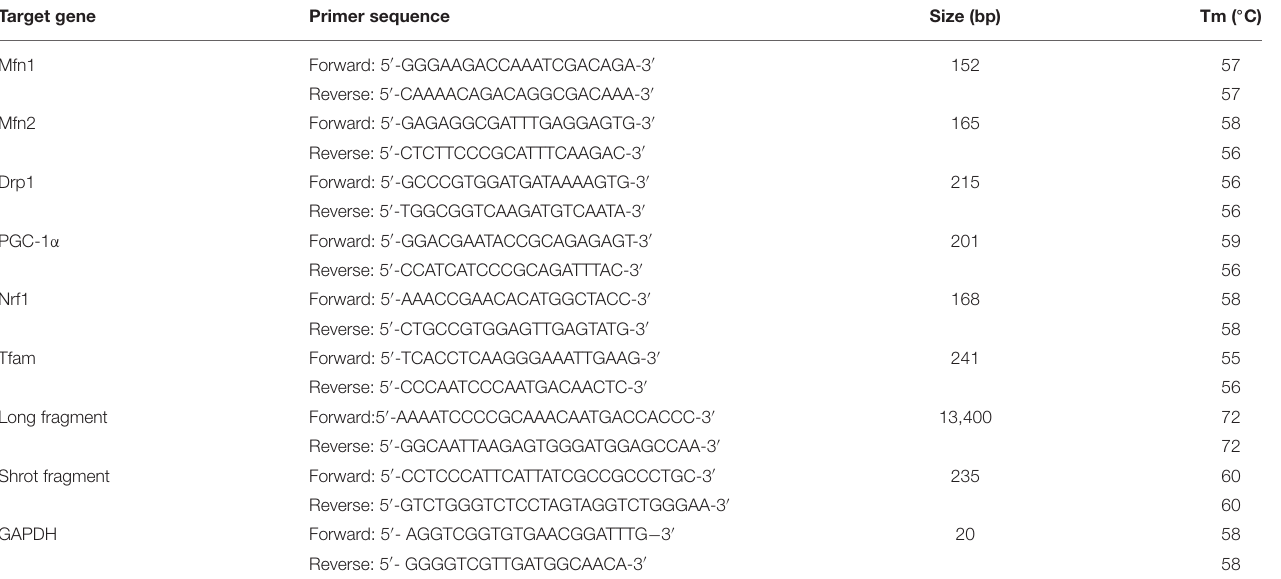
TABLE 2 | Sequence of primers for RT-PCR and long PCR. Target gene